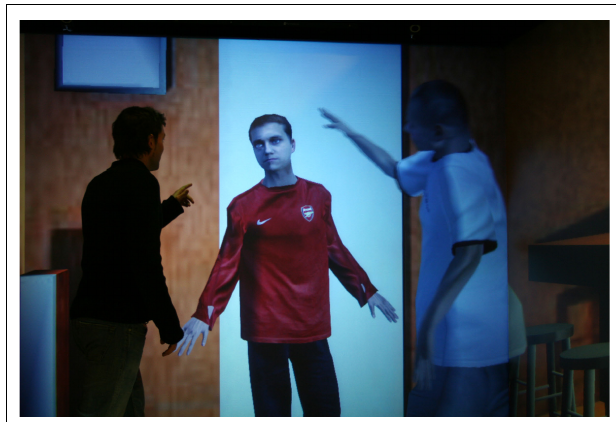
FIGURE 3 | The virtual characters are life-sized and can look the volunteer in the eye. This fi gure is for illustrative purposes, since the volunteer would normally be wearing the stereo